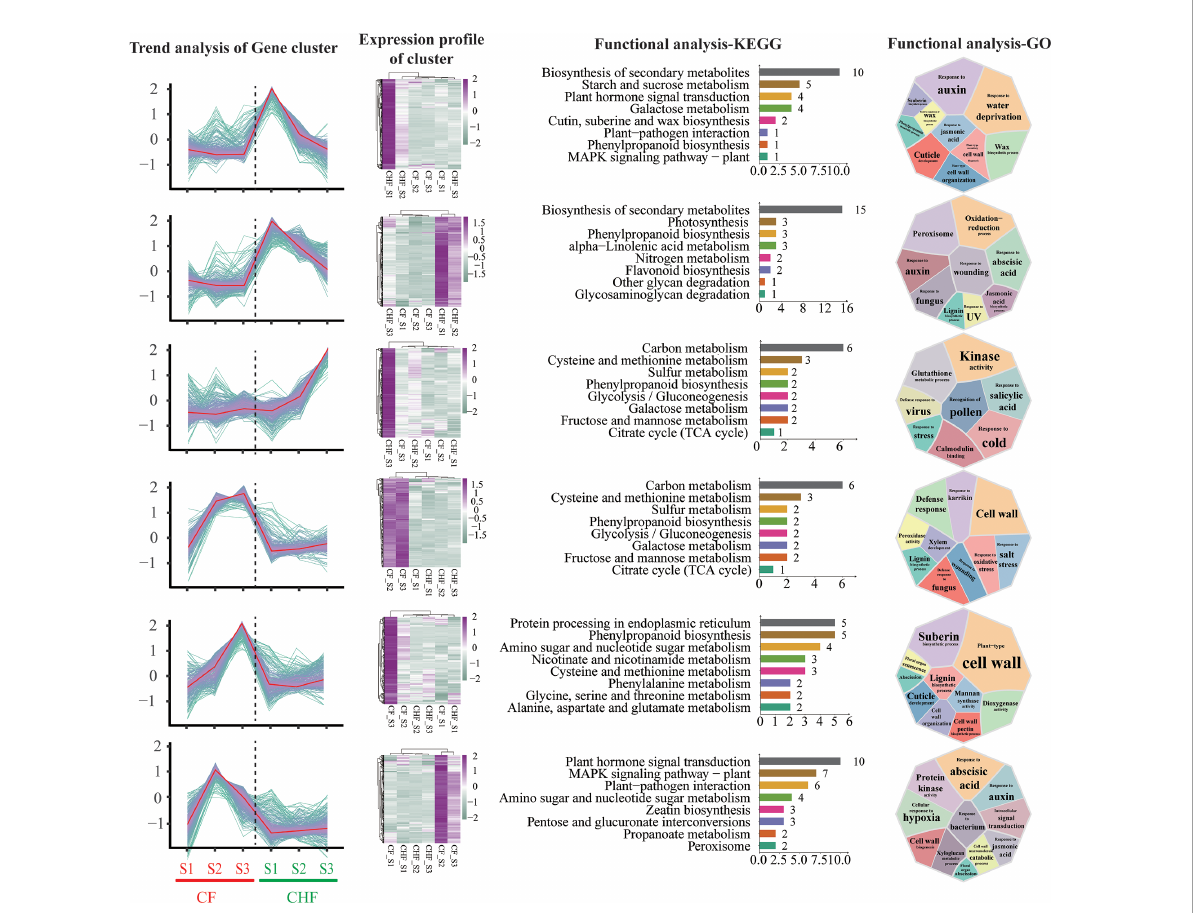
FIGURE 3 K-means cluster analysis of differentially expressed genes during the S1, S2, and S3 phases for CF and CHF. The fi rst column depicts the expression change trend of DEGs in each module, while the second column displays the expression heatmap of the module ’ s genes. The third column shows the KEGG functional analysis of the module ’ s genes, and the fourth column presents the GO functional analysis of the module ’ s